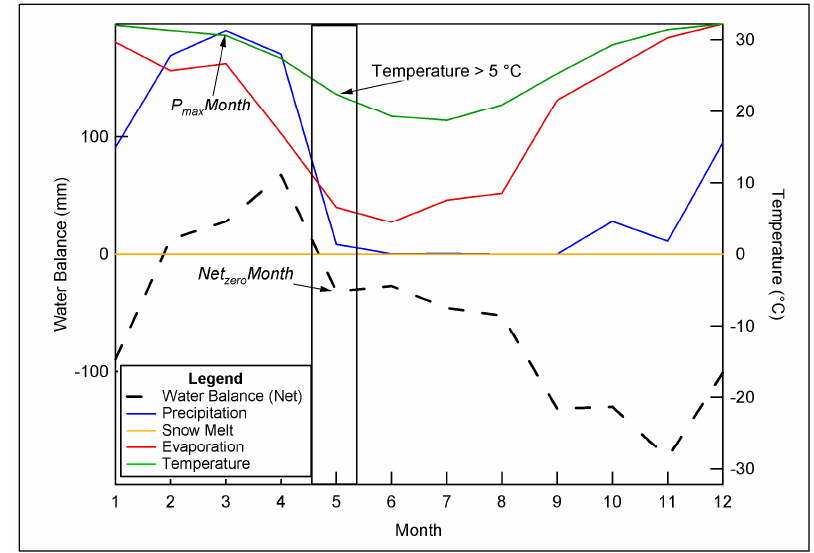
Figure 1. This schematic illustrates the optimal month selection method. The algorithm detects the zero-crossing month on the net water balance curve (black dashed line) after the rainy season, during the ice free period.